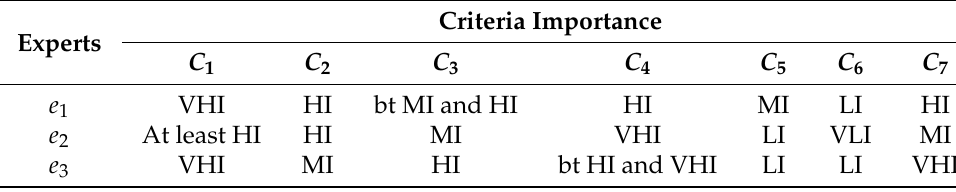
Table 5. Collected information of criteria importance W h provided by experts.